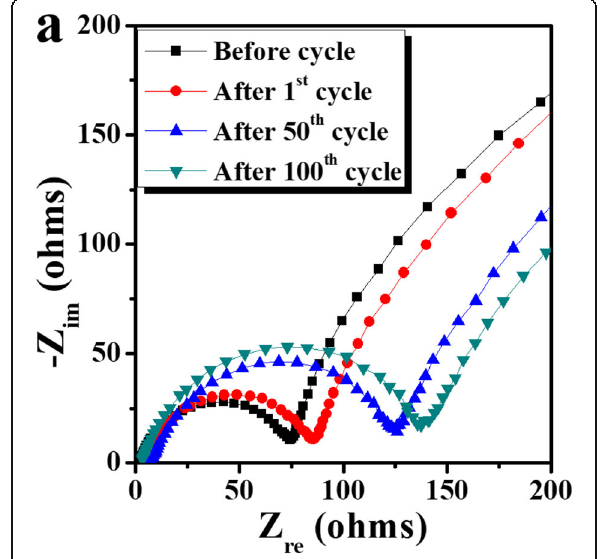
Fig. 4 Nyquist plots of the cells containing lithia/Li 2 RuO 3 nanocomposites before cycling and after selected cycles (1st, 50th, and 100th cycles)